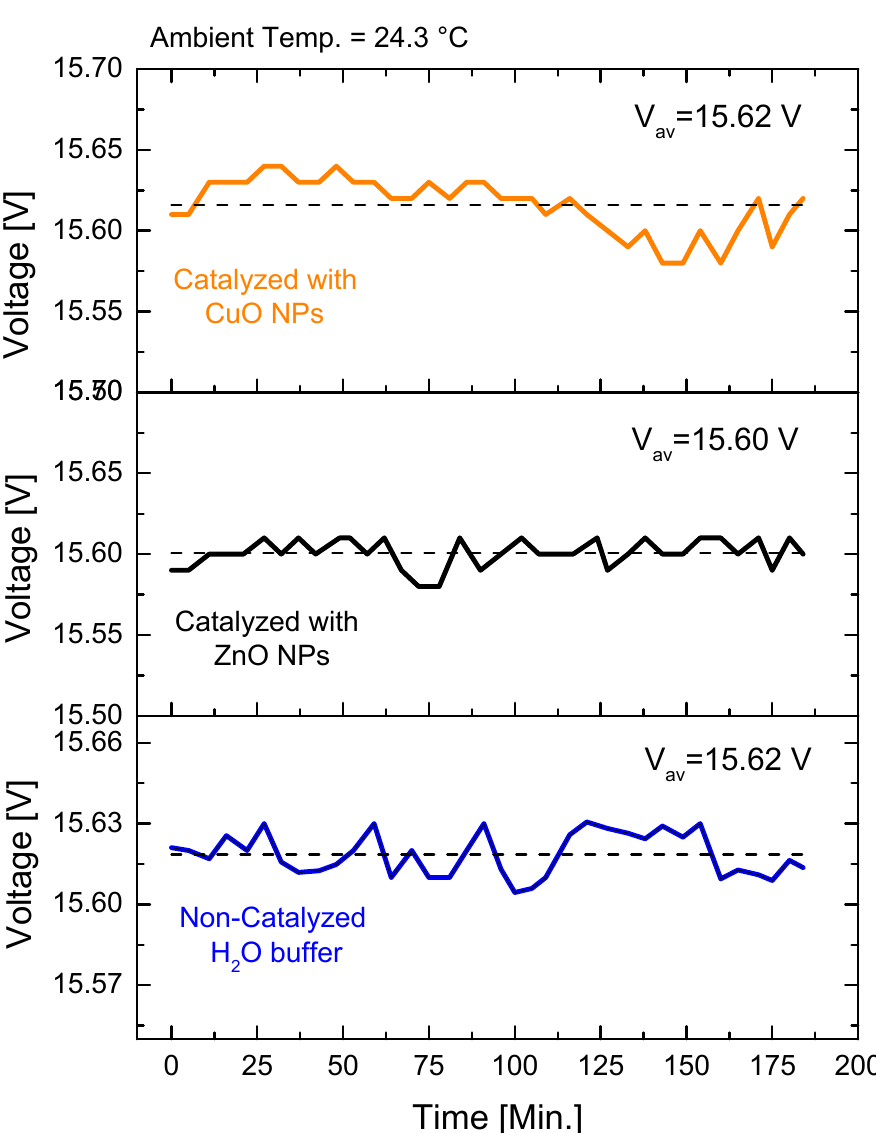
Figure 6. Voltage (V) versus period of Time (t) characteristic for the non-catalyzed system and the catalyzed systems with CuO NPs and ZnO NPs, respectively.